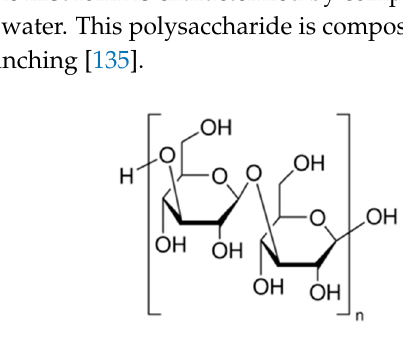
Figure 5. Idealized structure of the chemical units of laminaran.